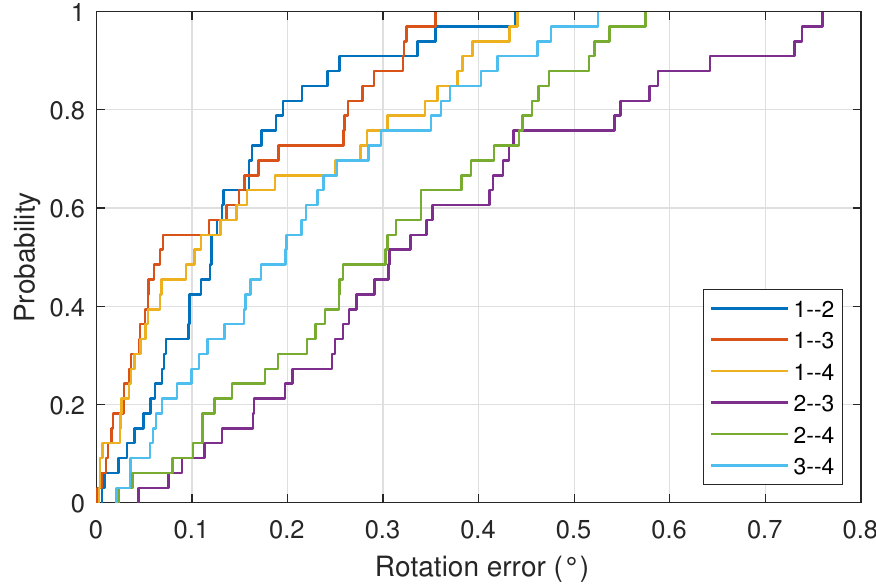
Figure 11. CDF of the rotation error for measurements carried out for all combinations of emitter